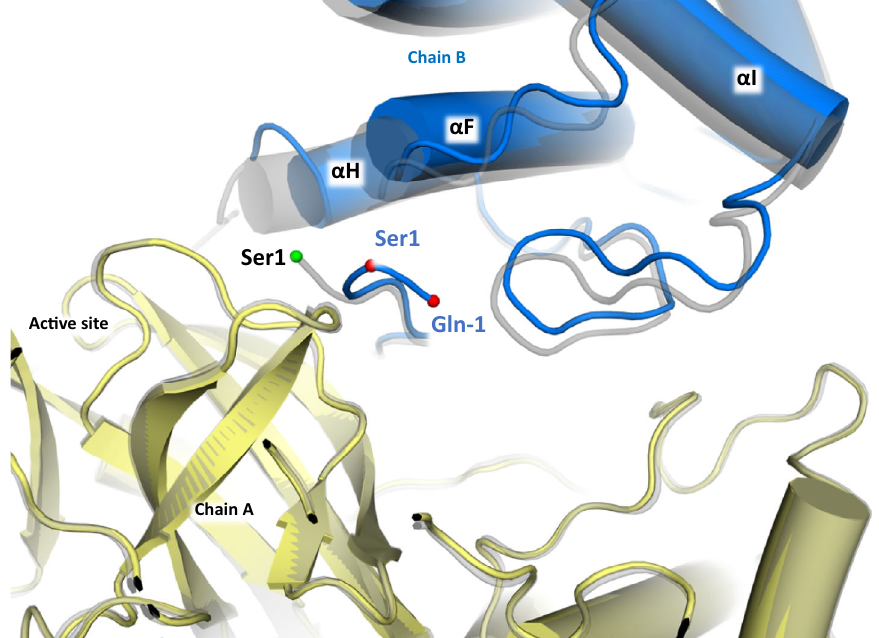
Fig. 7 | Cartoon model of X-ray structure of M pro C145S bound to Nirmatrelvir, with chain A showed in yellow, and chain B showed in blue. Ser1 and Gln-1 alpha carbons are highlighted as red spheres. Native M pro is shown as grey transparent cartoon, with Ser1 alpha-carbon highlighted as a green